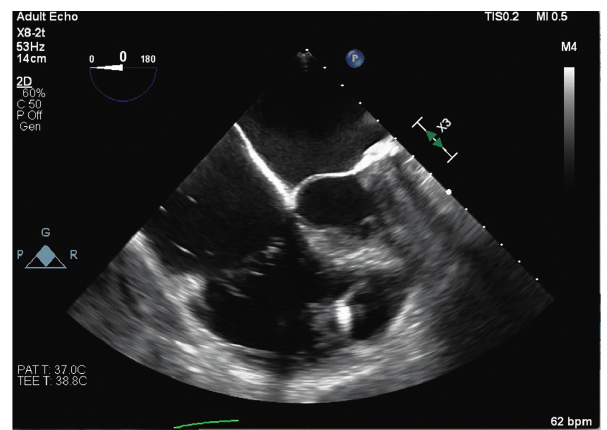
Figure 2: Transesophageal echocardiography, modified mid- esophageal four-chamber view demonstrating a leadless pacemaker in the right